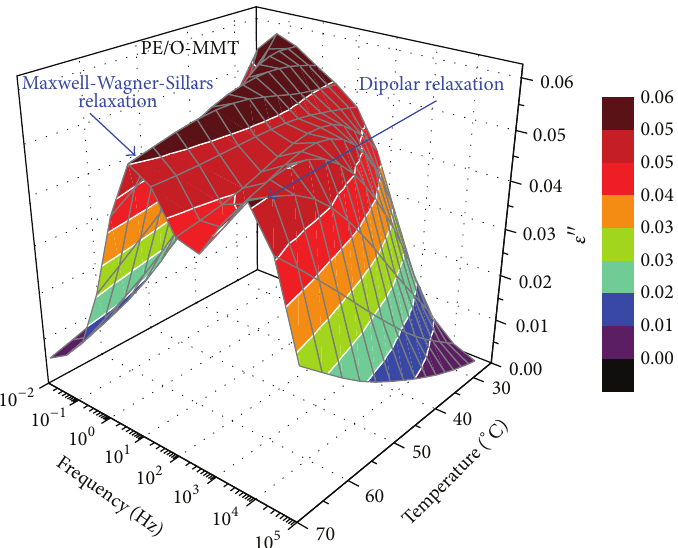
Figure 7: Dielectric loss (𝜀 󸀠󸀠 ) for PE/O-MMT nanocomposites versus frequency at various temperatures, plotted in 3D representation.